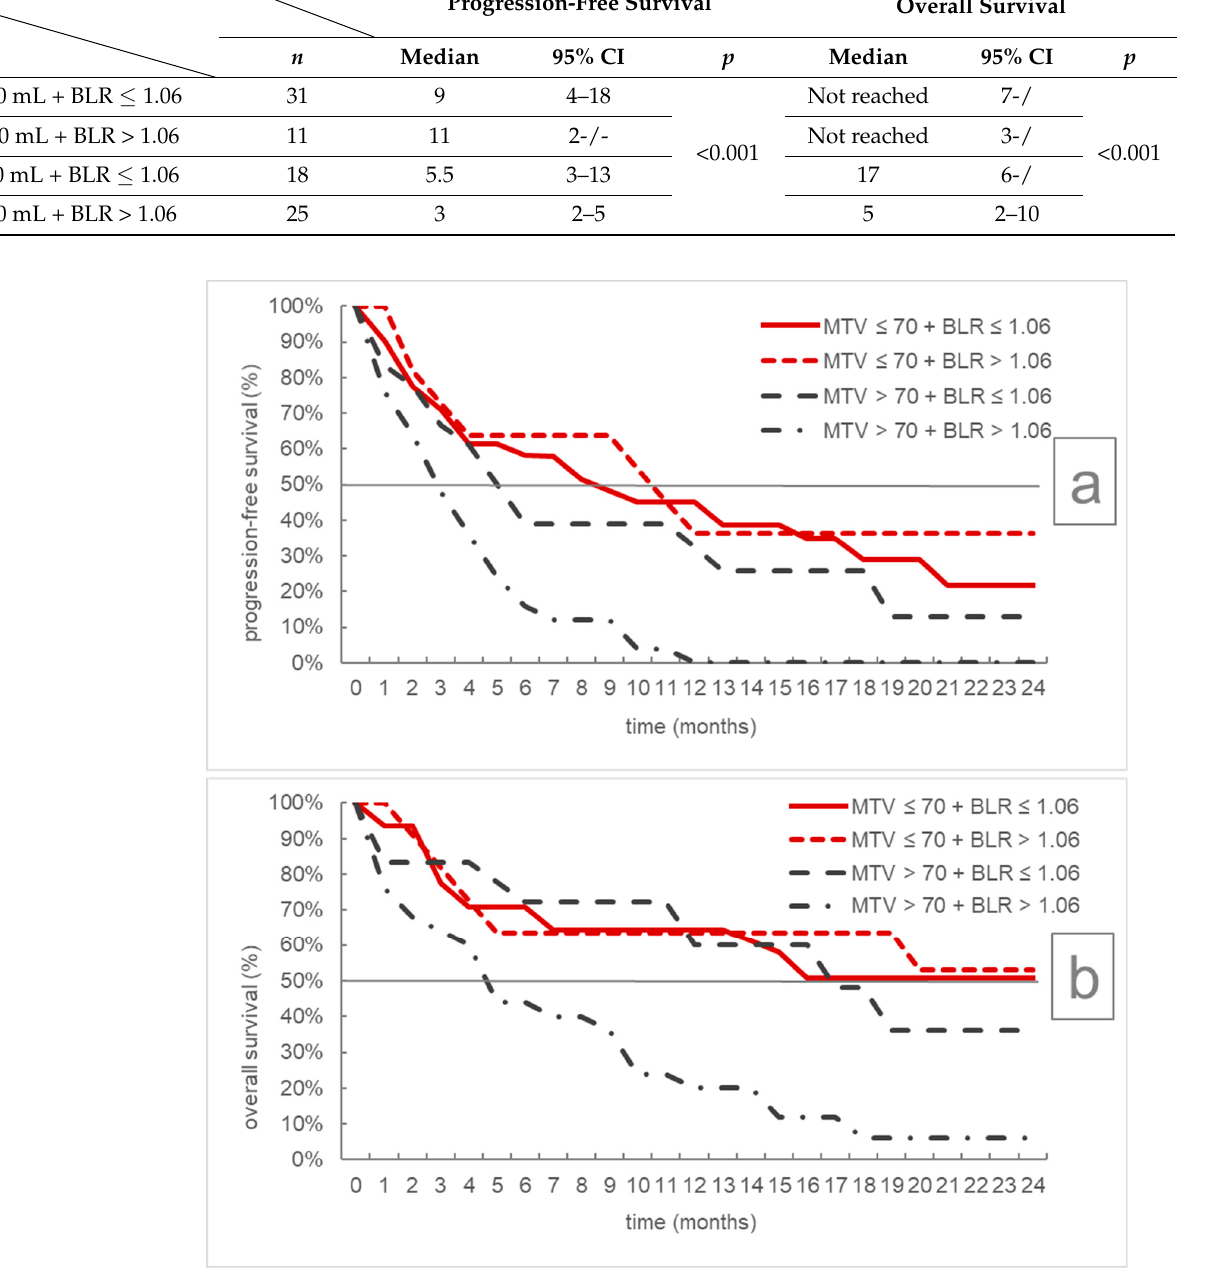
Figure 3. Kaplan–Meier curves for progression-free ( a ) and overall survival ( b ) according to combined MTV and BLR subgroups. MTV = metabolic tumor volume, BLR = bone marrow to liver ratio.